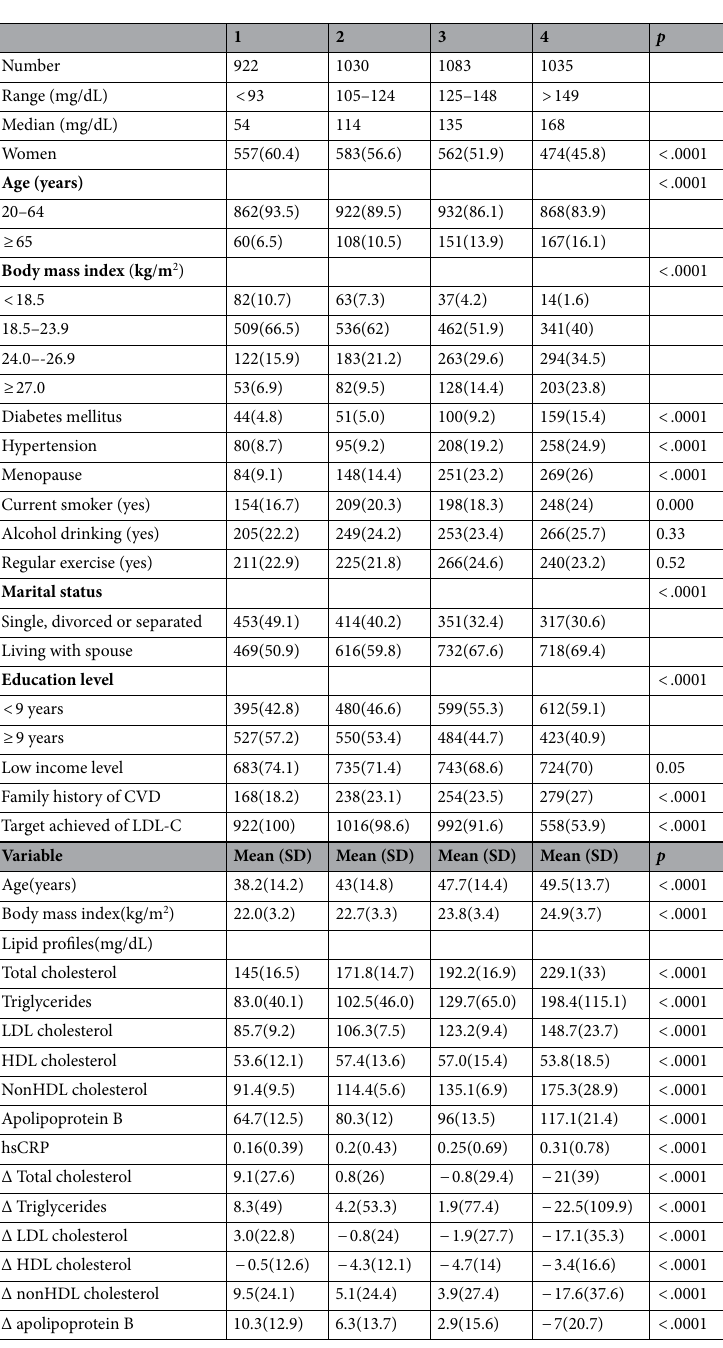
Table 1. Distribution of various baseline demographic, lifestyle, and socioeconomic factors in the study population, specified by NonHDL quartiles. CVD cardiovascular disease; LDL-C low-density lipoprotein cholesterol; HDL cholesterol high density lipoprotein cholesterol; NonHDL cholesterol non-high density lipoprotein cholesterol; To convert total cholesterol, LDL cholesterol, HDL cholesterol, nonHDL cholesterol and apolipoprotein B from mg/dl to mmol, divide by 38.46; To covert triglycerides from mg/dl to mmol , divide by